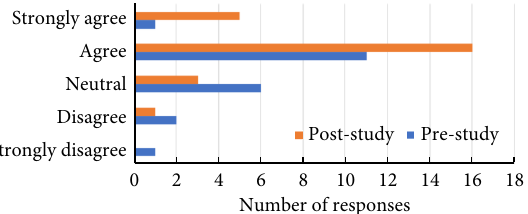
Fig. 10 Participants ’ self-reported capability of thinking from stakeholders ’ perspective before and after using FID.